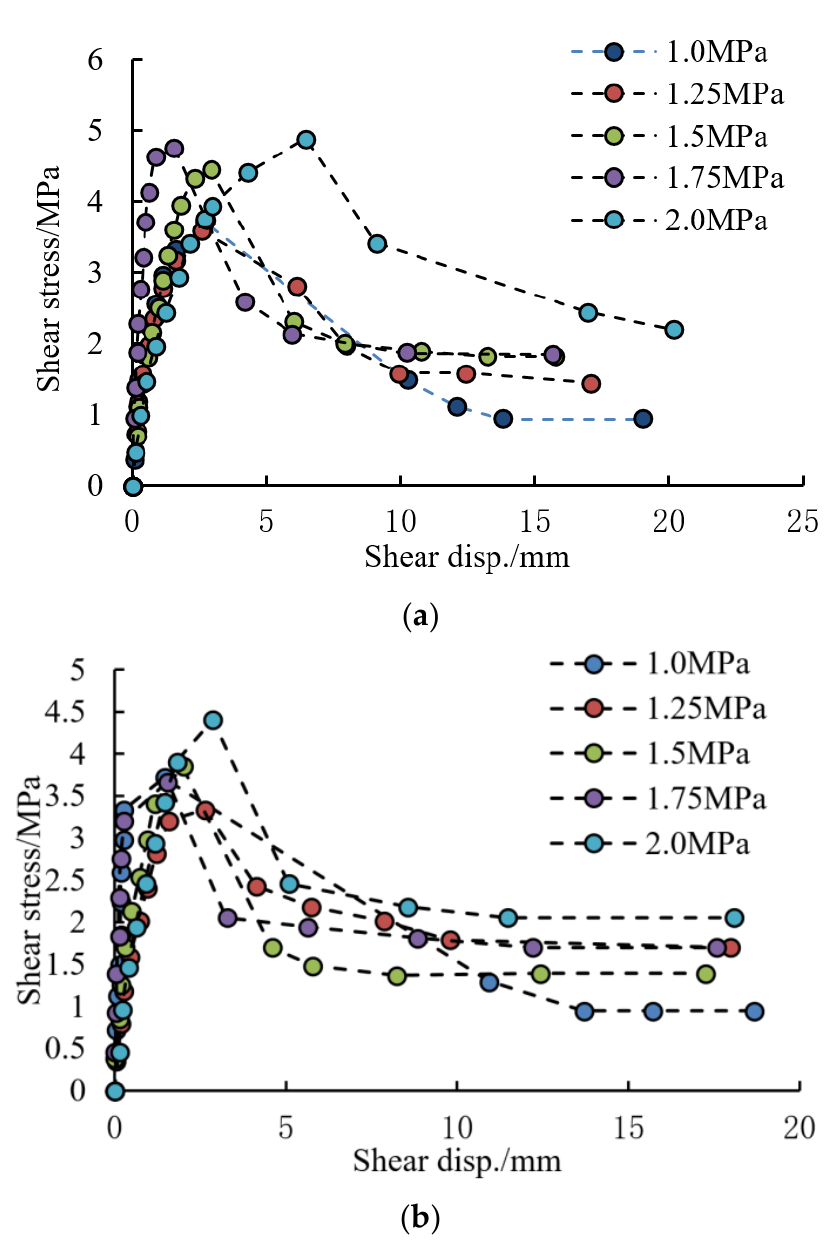
Figure 2. The in-situ direct shear test of the rock-concrete interface.